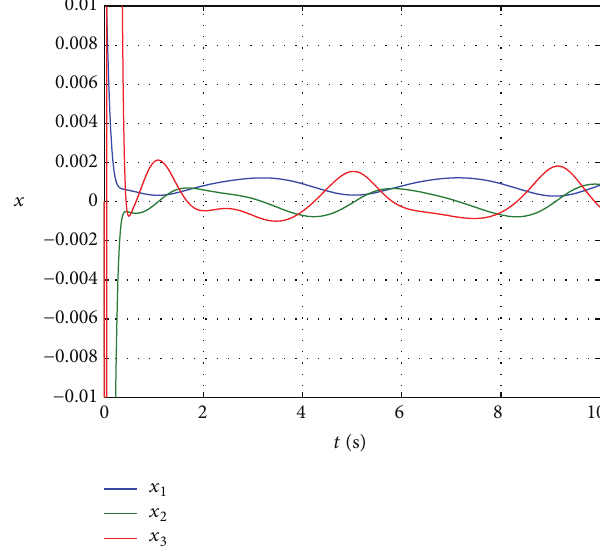
Figure 5: Trajectory of system state x